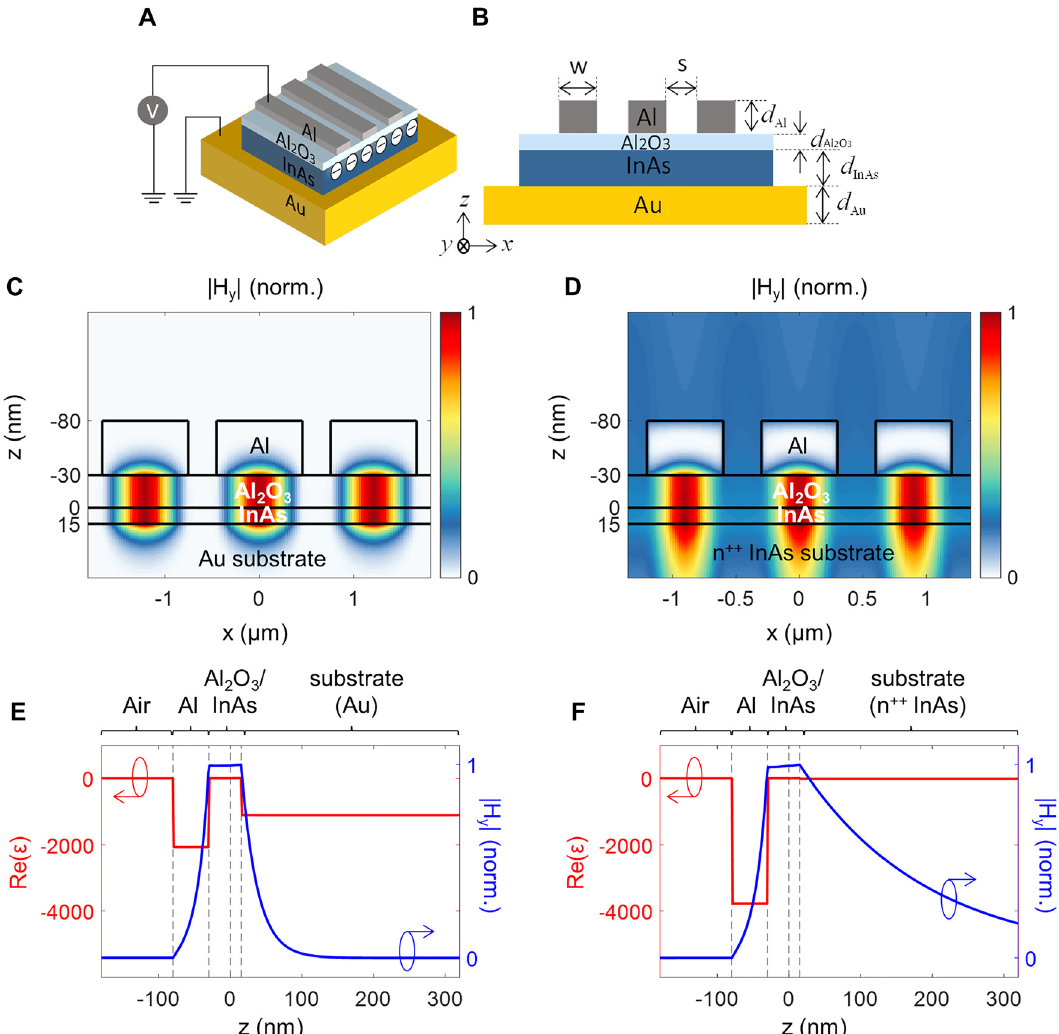
Figure 1: Configuration of the proposed metasurface with a strong light field confinement. (A) Bird ’ s eye-viewof the metasurface includingthreeAlantennaontop of anAl 2 O 3 layeras a dielectricinsulatorandan n -dopedInAslayeras an active layer, where the charge carrier concentration at the interface between the Al 2 O 3 and InAs layers can be controlled to manipulate the amplitudeandphaseofre fl ectedlight.(B)Cross-sectionalviewwiththedetaileddesignparameters. d Al :50nm, d InAs :15nmincommon. d Au is assumed to be semi-in fi nite. w , s , d Al2O3 are 660 nm, 50 nm, and 5 nm, respectively, for the amplitude modulation, and 910 nm, 30 nm, and 30 nm, respectively, for the phase modulation. (C) Magnitude of the magnetic fi eld distribution at a resonance of the gap plasmon mode formed between the top Al strip antenna and the bottom Au substrate. w , s , d Al2O3 are 910 nm, 300 nm, and 30 nm. The wavelength is 4.7 μ m, andtheincidentbeamhasthenormalangleandtheelectrical fi eldperpendiculartoAlstripantennas.Weobserveagigantic fi eldcon fi nement inthecavitymadeofInAslayerandanegligiblepenetrationintotheAusubstrate.(D)Magnitudeofmagnetic fi elddistributionforthecasewith the high-doped ( n ++ ) InAs substrate as in Ref. [25] ( N d = 10 20 /cm 3 ) (see Table 1 for details). w , s , d Al2O3 are 600 nm, 300 nm, and 30 nm. The wavelength is 6.6 μ m.It is clearlyseen thatthe gap plasmonexhibitslonger penetrationinto thesubstrate comparedto (C). (E)Spatial pro fi le of the real part of permittivity (red line, left y -axis) and the normalized magnitude of the y -component of the magnetic fi eld (blue line, right y - axis)inthepresenceoftheAusubstratein(C),showingsmallpenetrationdepthtothesubstrateandstronglight fi eldcon fi nementatthecore. (F) Spatial pro fi le for the high-doped substrate as in (D), showing substantial penetration depth to the substrate and thus lower light fi eld con fi nement at the In Figure 1E, we plot the real part of the relative electric of the Al grating is around − 2068, and that of the Au sub- permittivity (Re( ε ), left y -axis) and the y -component of the strate is around − 1099 at the wavelength of 4.7 μ m. The magnetic fi eld (right y -axis) of the gap plasmon modes in mode index of the gap plasmon is around 2.39, and the the structure for the Au substrate case (Figure 1C). The Re( ε ) penetration depth into the Au substrate is 22.3 nm. As a